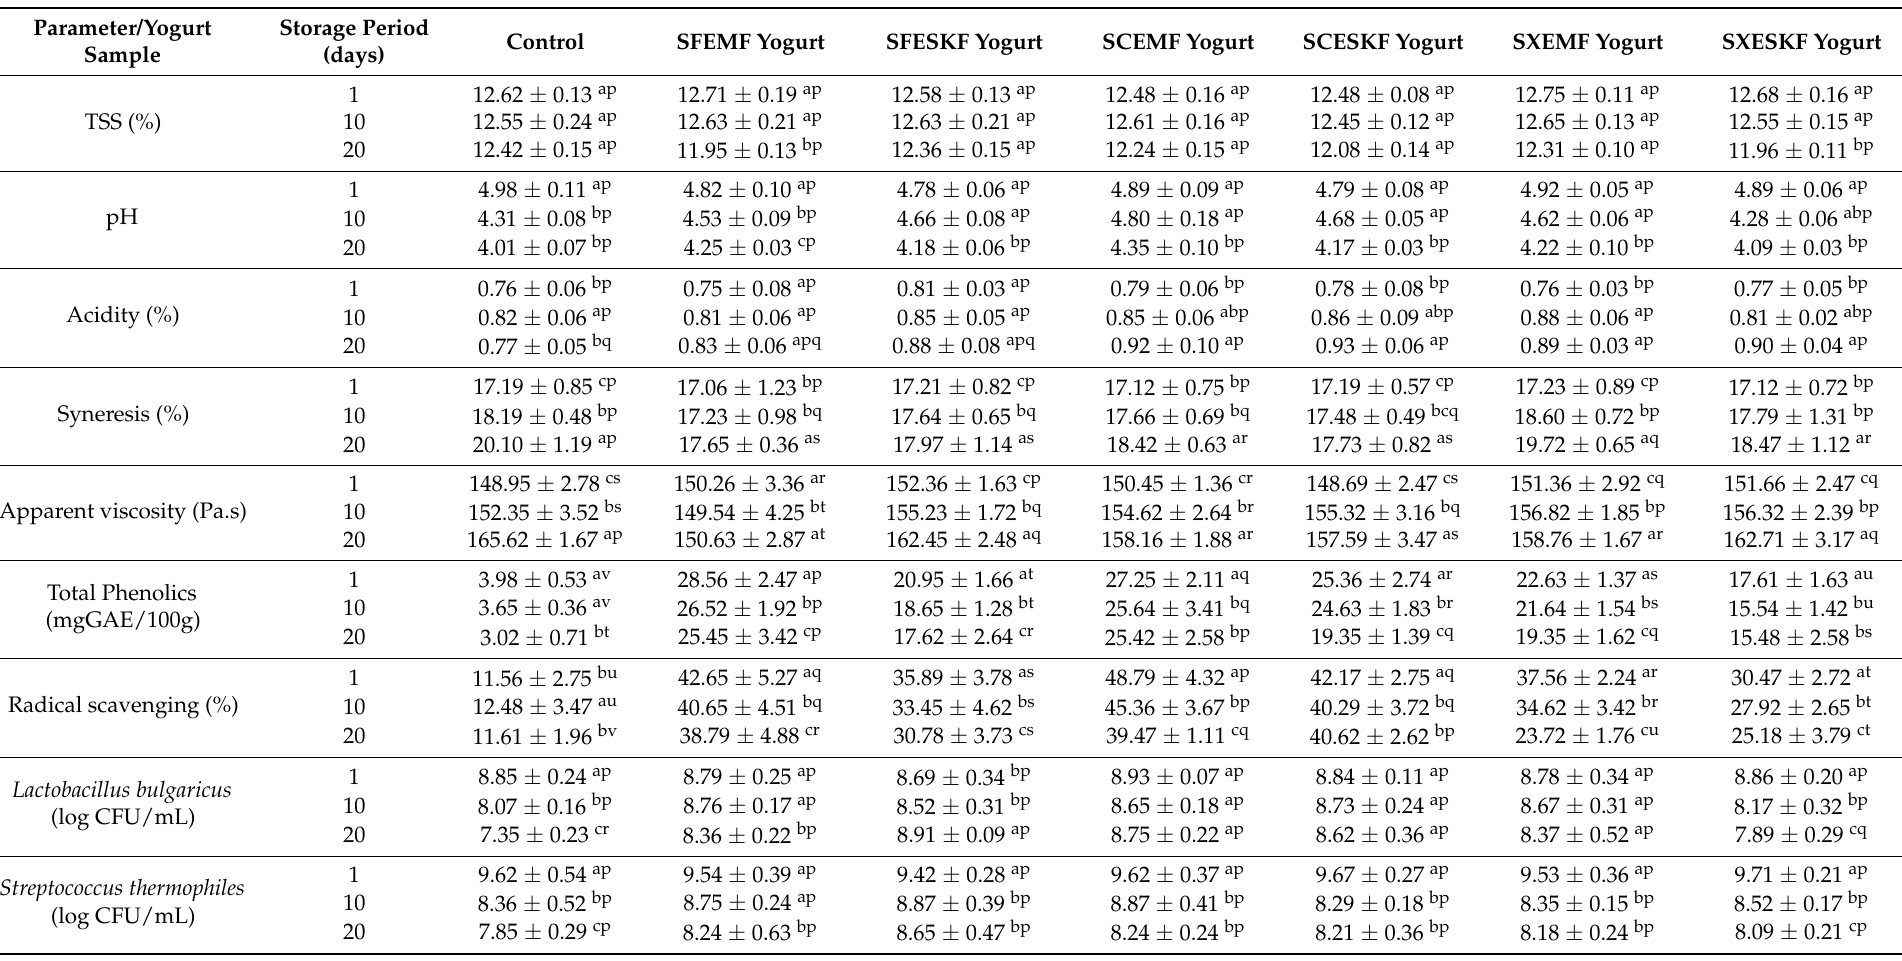
Table 2. Physicochemical parameters of functional liquid yogurt containing extracts from Majdool (MF) and Sukari flesh (SKF) obtained using supercritical fluid (SFE), subcritical CO 2 (SCE) and Soxhlet (SXE) extraction techniques during storage at 4 ◦ C for 20